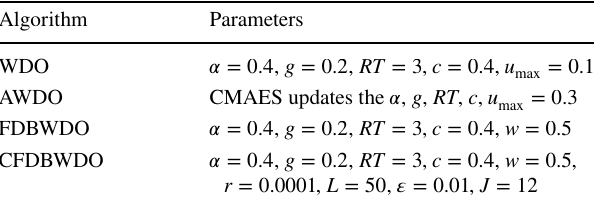
Table 3 Parameter settings of four WDO variants Algorithm Parameters